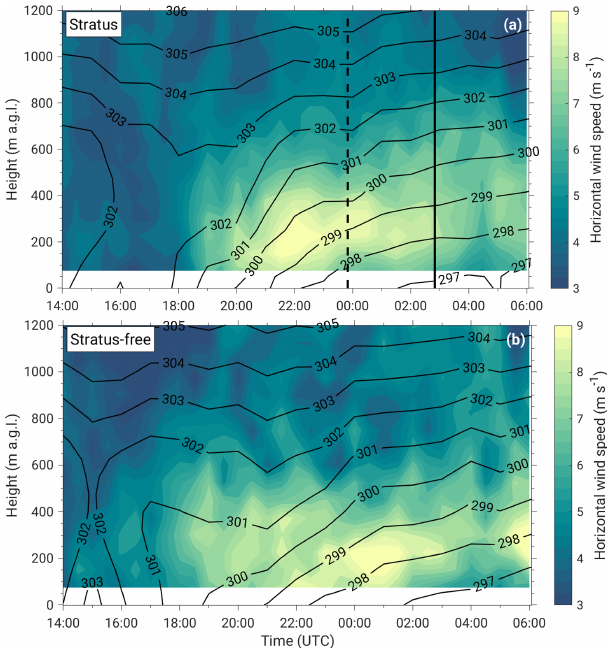
Figure 5. Time–height median composite of horizontal wind speed measured with UHF wind profiler (color) and potential temperature obtained from microwave radiometer (black isolines) for stratus (a) and stratus-free (b) nights at Savè supersite. The vertical dashed and solid lines in panel (a) indicate the beginning of stratus fractus and stratus phases for stratus nights,